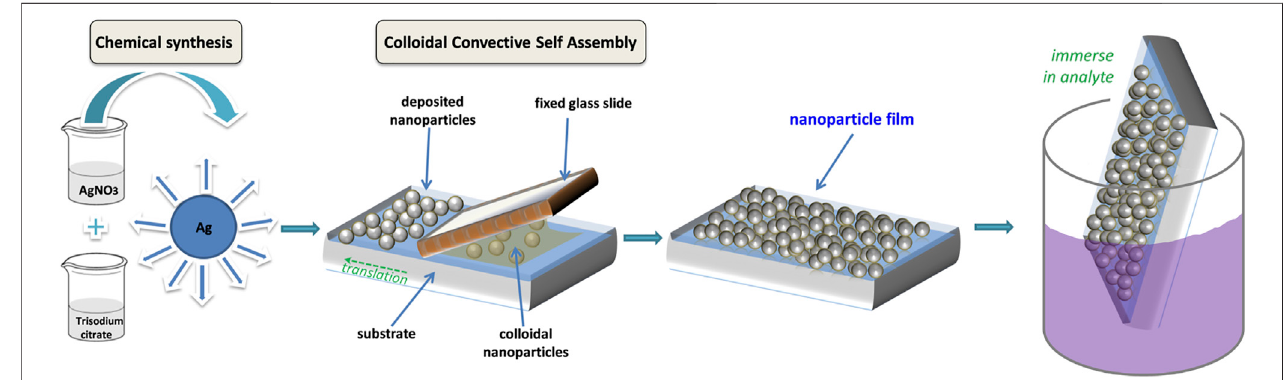
FIGURE 1 | Schematized protocol for fabrication of AgNP fi lms for use as SERS substrate: AgNP are chemically synthesized, then assembled into fi lms on solid substrates; the fi lms are then immersed in analyte solutions before SERS measurements.